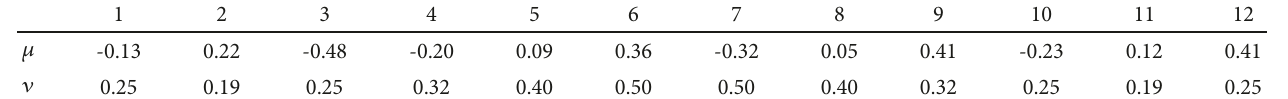
Table 2: The values of μ and ν ( θ